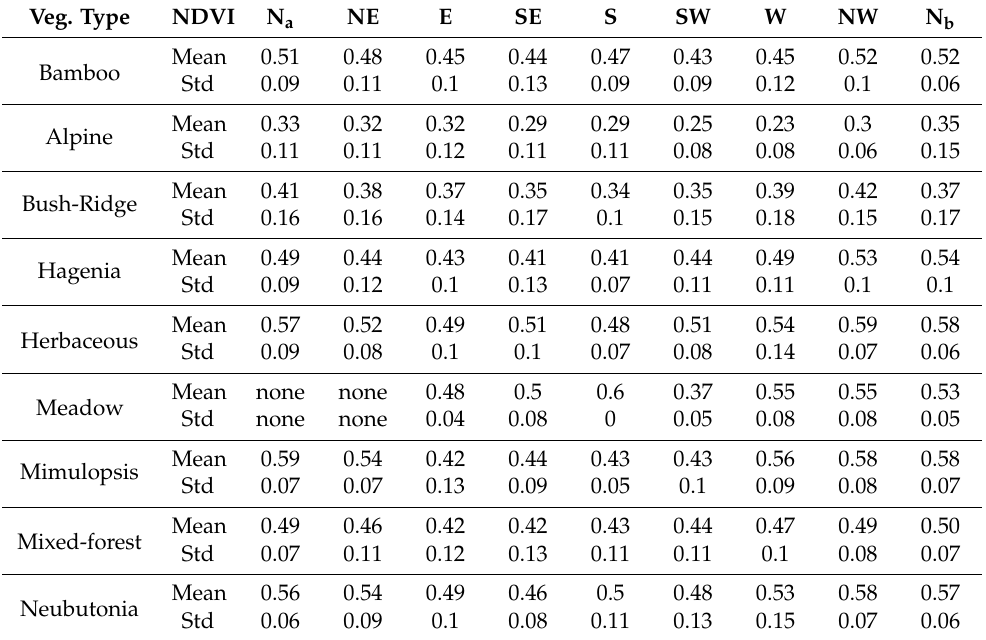
Table 4. Change of mean and standard deviation of NDVI per aspect and per vegetation cover